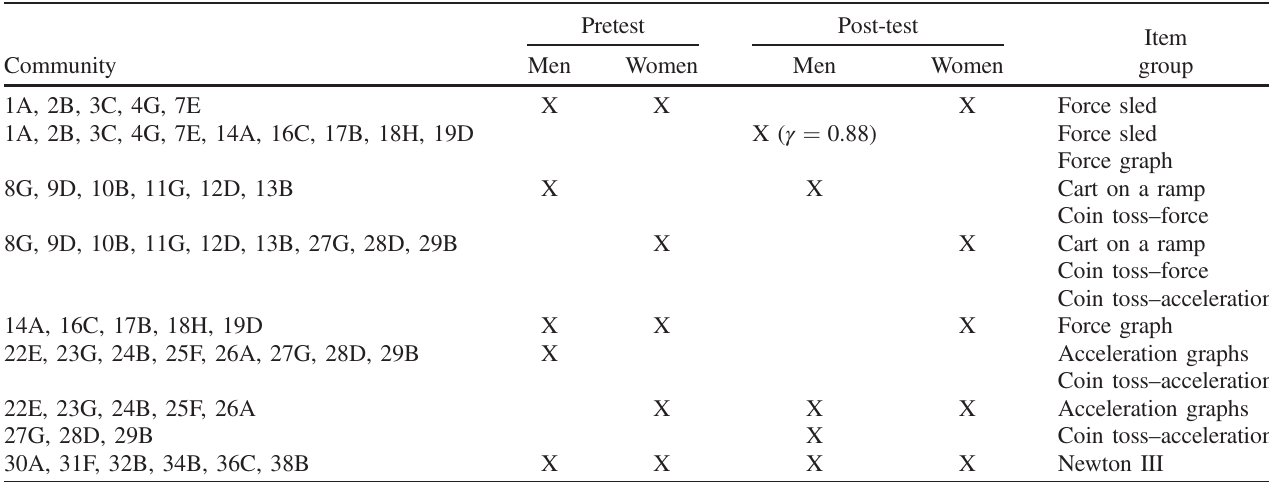
TABLE II. Communities identified in the pretest and post-test incorrect answers at r > 0 . 2 and community fraction, C > 0 . 8 . Only nodes selected by 20% of the students are included. Problematic items identified in Study 1 and Study 2 have been eliminated. The number in parentheses is the intracommunity density γ for communities where the intracommunity density is not